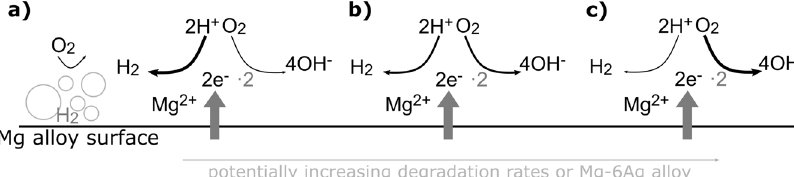
Fig. 7 Schematic drawing of the observed inverse relationship between ORR and HER activity. a When H 2 evolution is high, gas bubbles on the Mg alloy surface will hinder access of O 2 to the sample surface and lower the ORR. b Intermediate stage. c High rates of O 2 consumption are related to lower H 2 evolution. The study results indicate that higher ORR may be related to the Mg – 6Ag alloy in particular and increased degradation rates for other